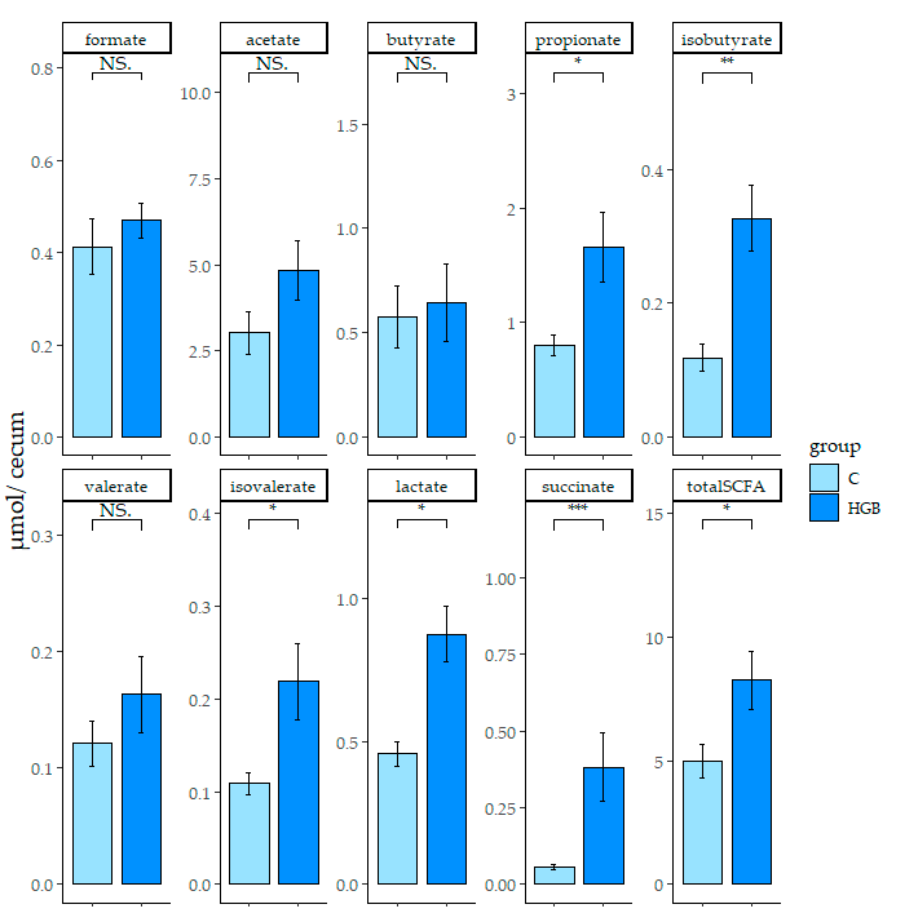
Figure 2. The concentration of short-chain fatty acids (SCFAs), lactate, and succinate in the cecum digesta. Values are means ± SE, n = 8. * p < 0.05, ** p < 0.01, *** p < 0.001 showed a significant difference between each group, “NS” is not significant. C: control group, HGB: high β -glucan barley group. Table 1. Counts of the predominant bacterial groups in the cecum digesta between the control and HGB